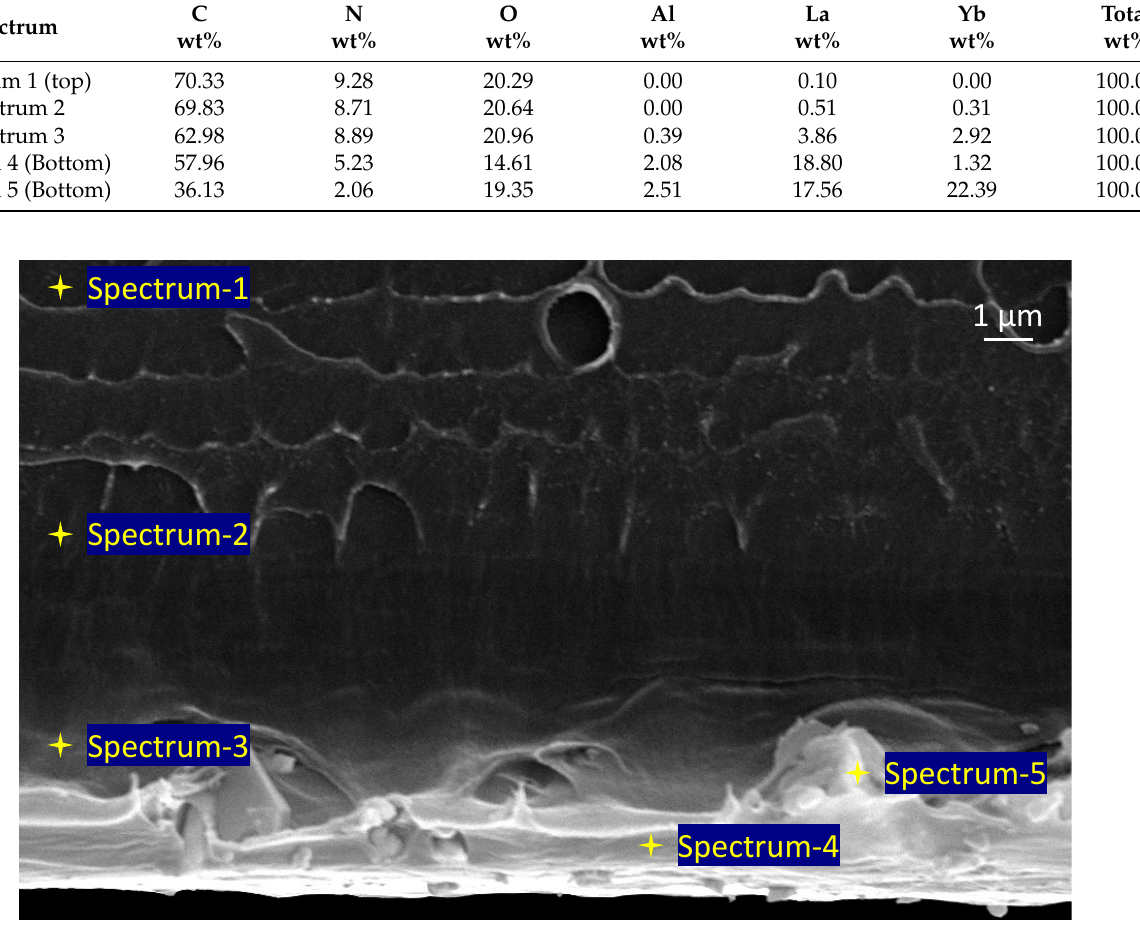
Figure 7. SEM micrographs of the PEI/LYA(2%) membrane, where the positions of spectral points 1–5 are indicated.